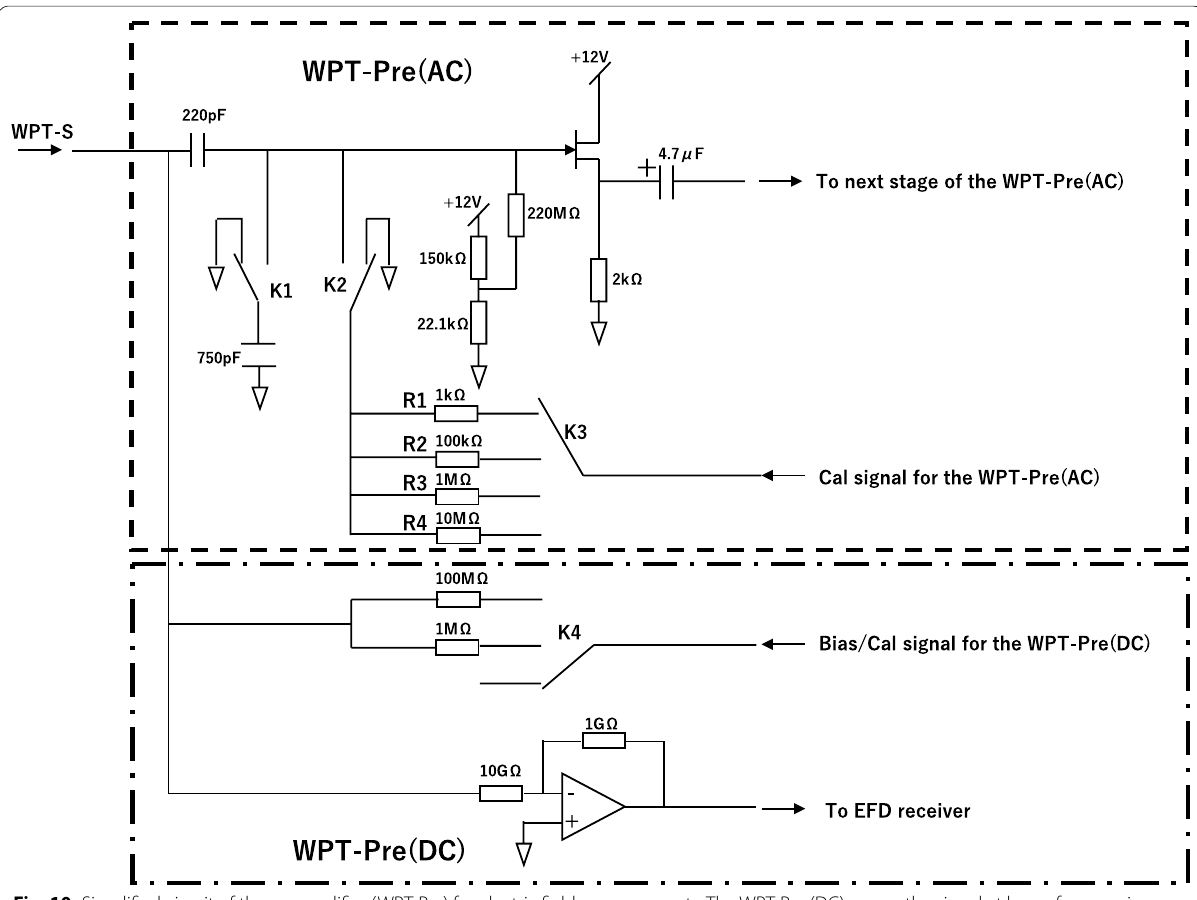
Fig. 10 Simplified circuit of the preamplifier (WPT-Pre) for electric field measurements. The WPT-Pre (DC) covers the signal at lower frequencies from DC to ~ 200 Hz, while the WPT-Pre (AC) is dedicated to measuring frequencies above a few